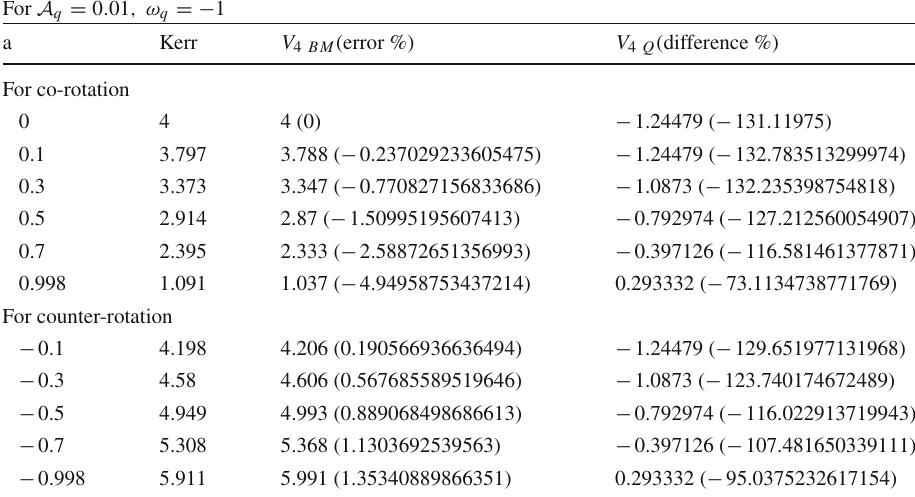
For A q = 0 . 01 , ω q = −